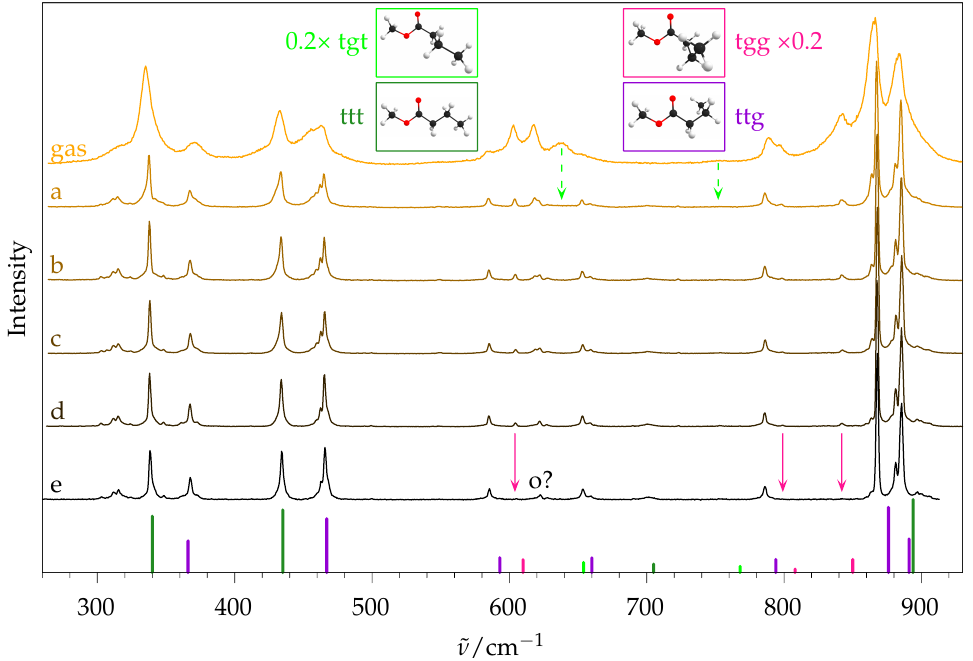
Figure 11. Raman spectra of methyl butanoate, sorted by descending effective temperature. Top trace: gas phase spectrum at room temperature. a–e: jet spectra with same substance concentration (1.50 in Figure 10), but different nozzle temperatures T N and distances between nozzle and laser beam r . ( a ) T N = 150°C, r = 0.5mm. ( b ) T N = 150°C, r = 1.0mm. ( c ) T N = room temperature, r = 0.5mm. ( d ) T N = room temperature, r = 1.0mm. ( e ) like d with 20% helium replaced by argon. Vertical bars at the bottom: selection of intense lines of the four conformers, relative intensities of tgt and tgg scaled by 0.2.